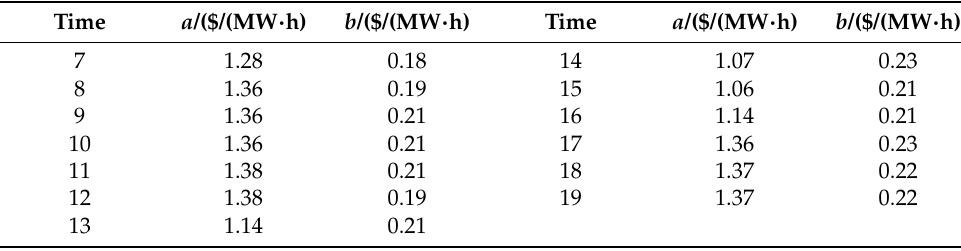
Table A4. Quotation factor for PV producer